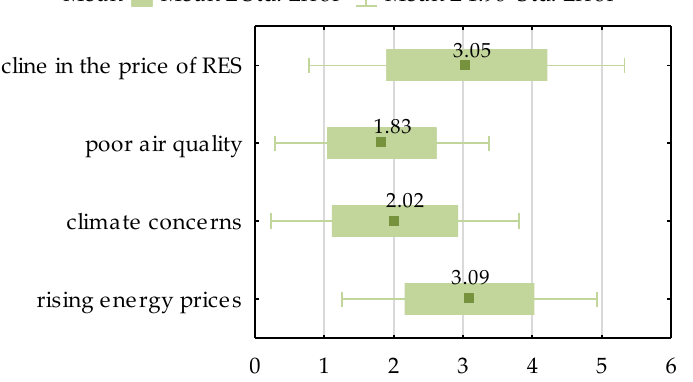
Figure 14. Assessment of factors encouraging users to invest in buildings using only renewable energy sources.